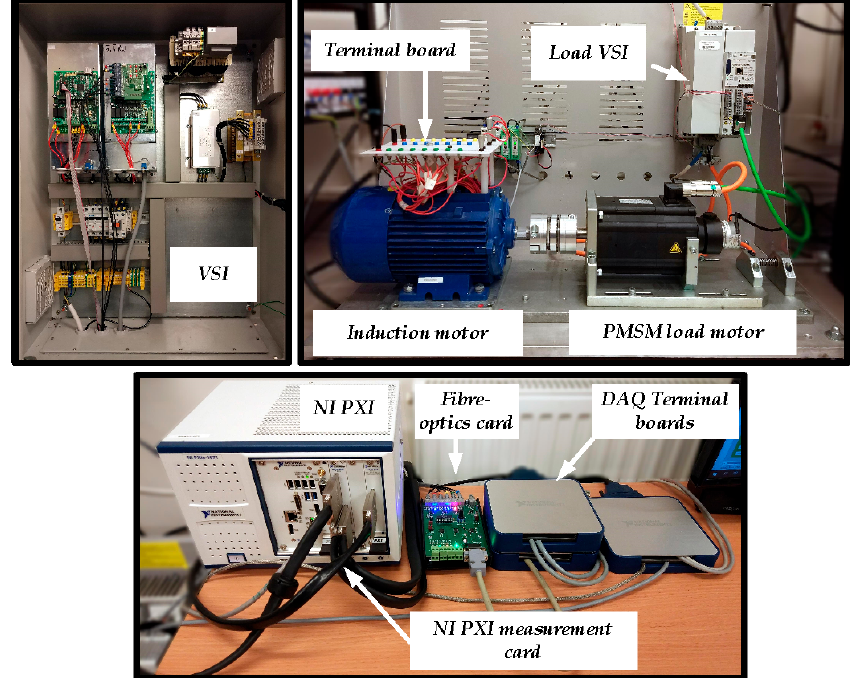
Figure 5. Photo of the experimental setup. VSI: voltage source inverter.